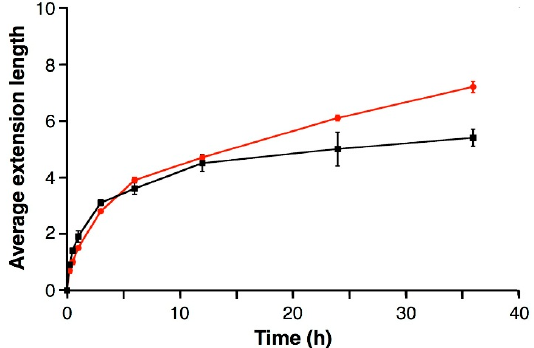
Figure 3. Time-course analysis of the TdT-catalyzed polymerization of d H TP in the presence of 2.0 mM (red circles) and 10 mM (black squares) of Mg II ions. Primer (5 ′ -FAM-dT 20 -3 ′ ): 5.0 µM, d H TP: 100 µM (20 equivalents), TdT: 2 U/µL, MgCl 2 : 2.0 or 10 mM, 37 °C. Average extension length was estimated based on the intensity of the bands on the gel. Averages of at least three independent experiments are shown in the figure. Error bars indicate the standard errors.